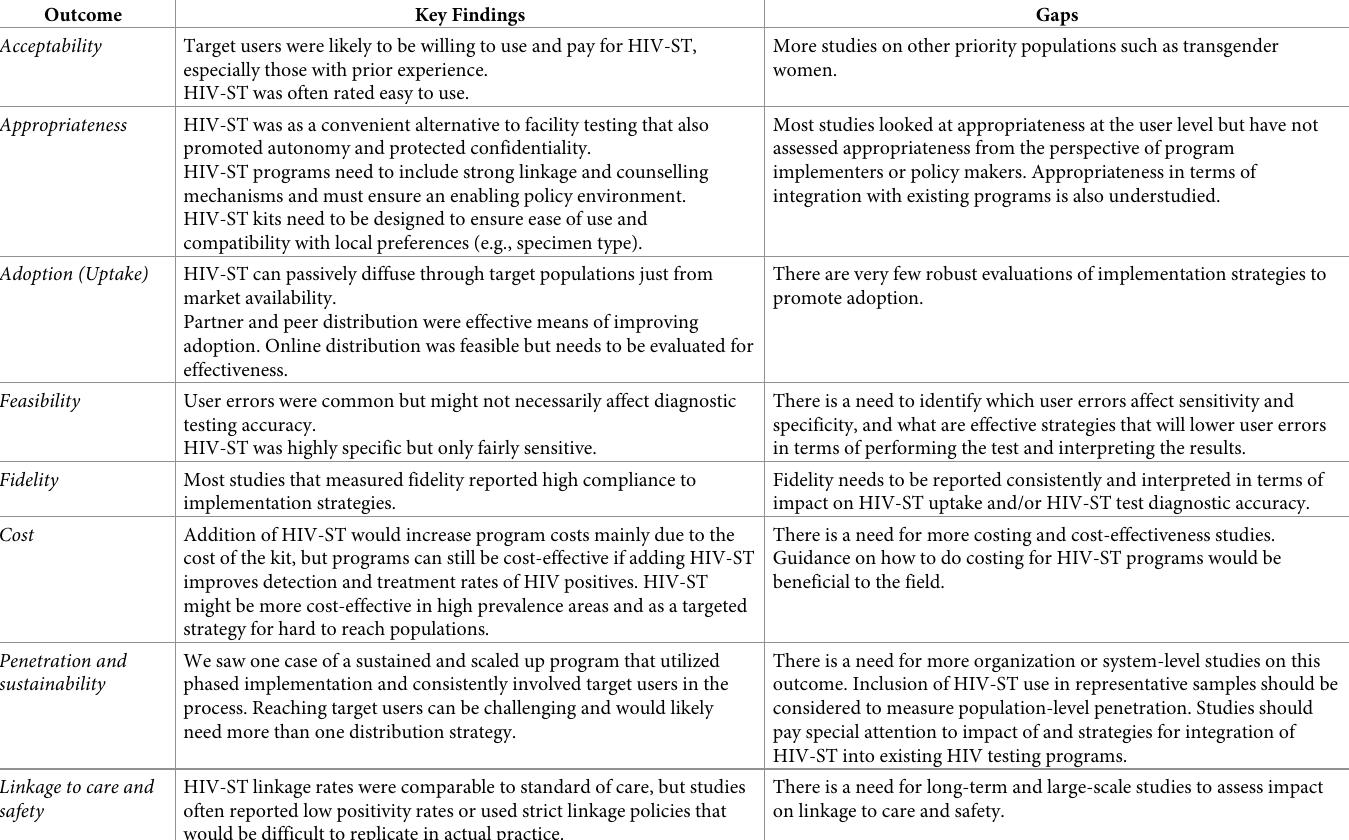
Table 2. Summary of findings and gaps according to implementation outcomes. Outcome Key Findings